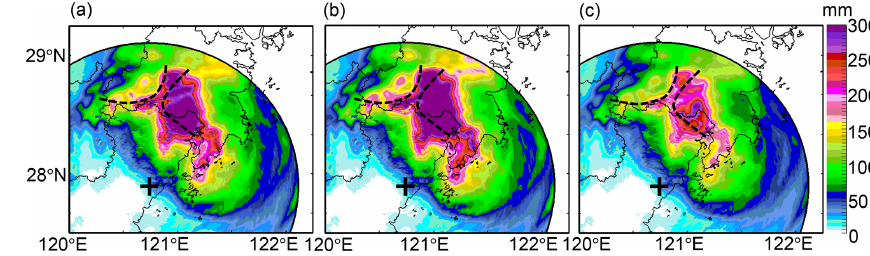
Figure 25. The same as Fig. 21, but (a) – (c) were calculated with Eqs. (14a)–(14c), respectively.